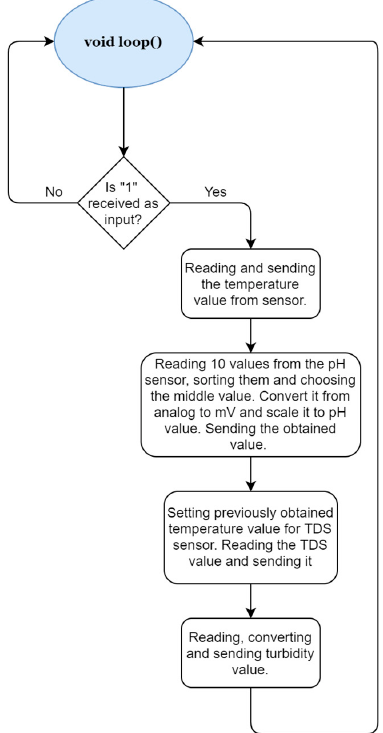
Figure 9. Diagram for the software implemented on the Arduino board.